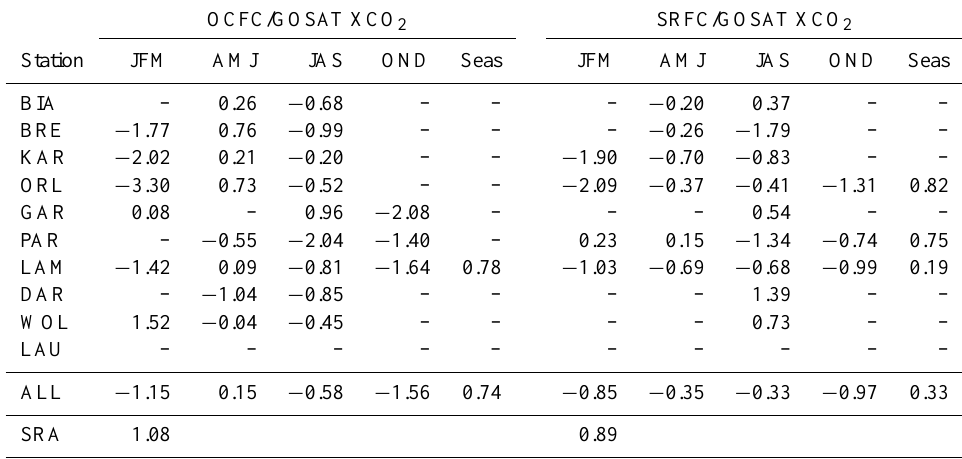
Table 6. OCFC and SRFC XCO 2 seasonal mean bias, seasonality and SRA results. All results are in ppm units.